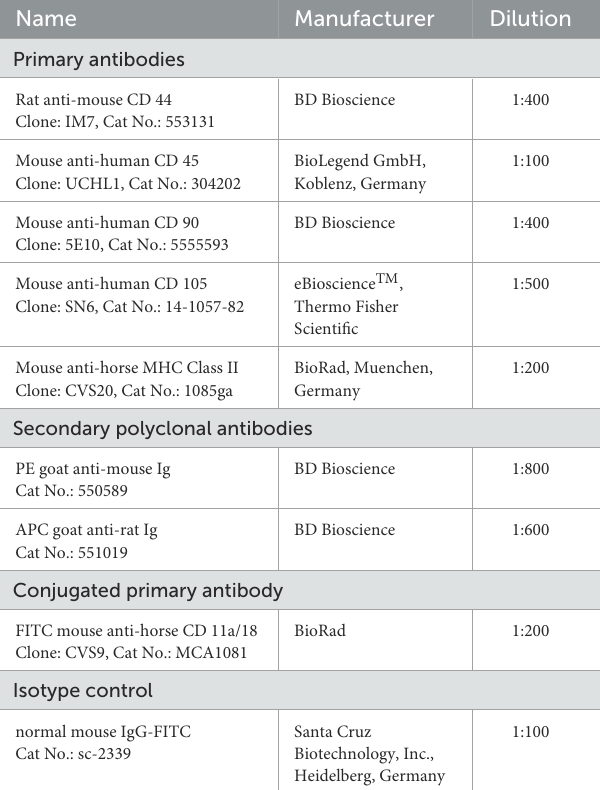
TABLE 3 Antibodies for